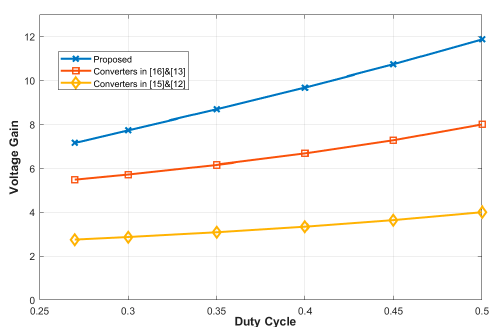
Electronics 2020 , 9 , x FOR PEER REVIEW Figure 8. Gain comparison for the proposed converter against other converters. Figure 8. Gain comparison for the proposed converter against other converters.